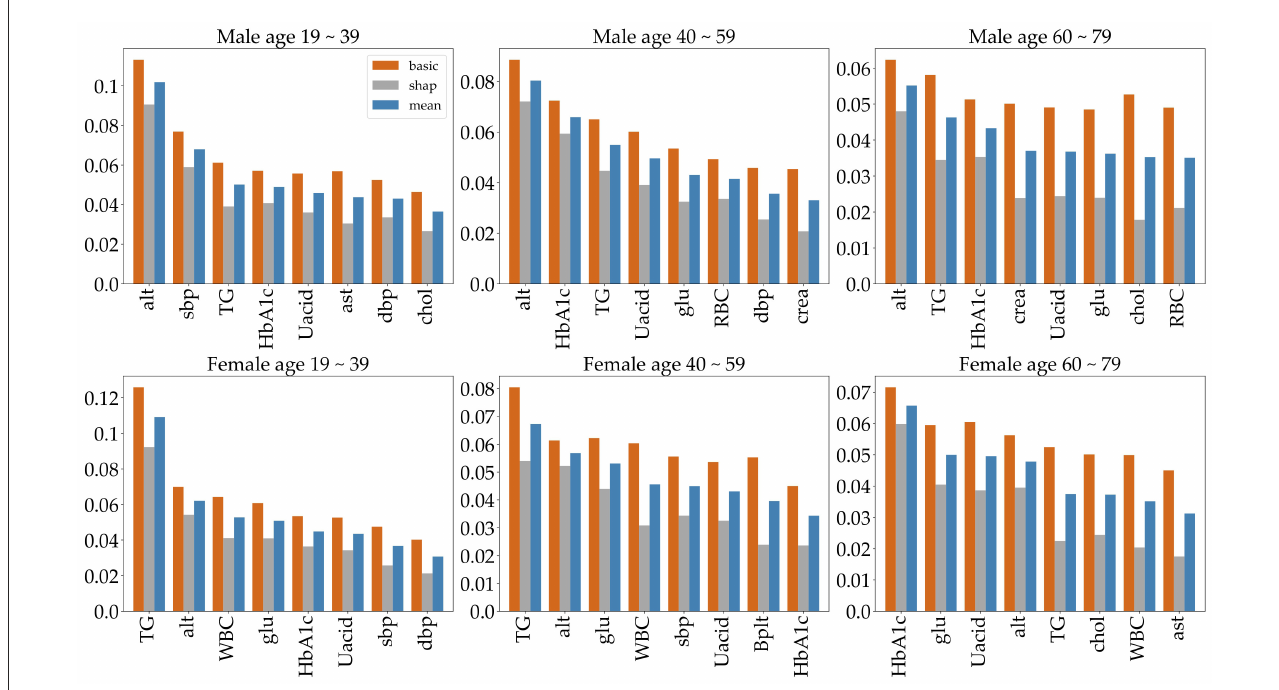
FIGURE4 The top eight important features, selected by age group and gender. To indicate feature importance, the orange bar represents the random forest value, and the gray bar represents the average absolute sharp value. The blue bar shows the mean of the two values.